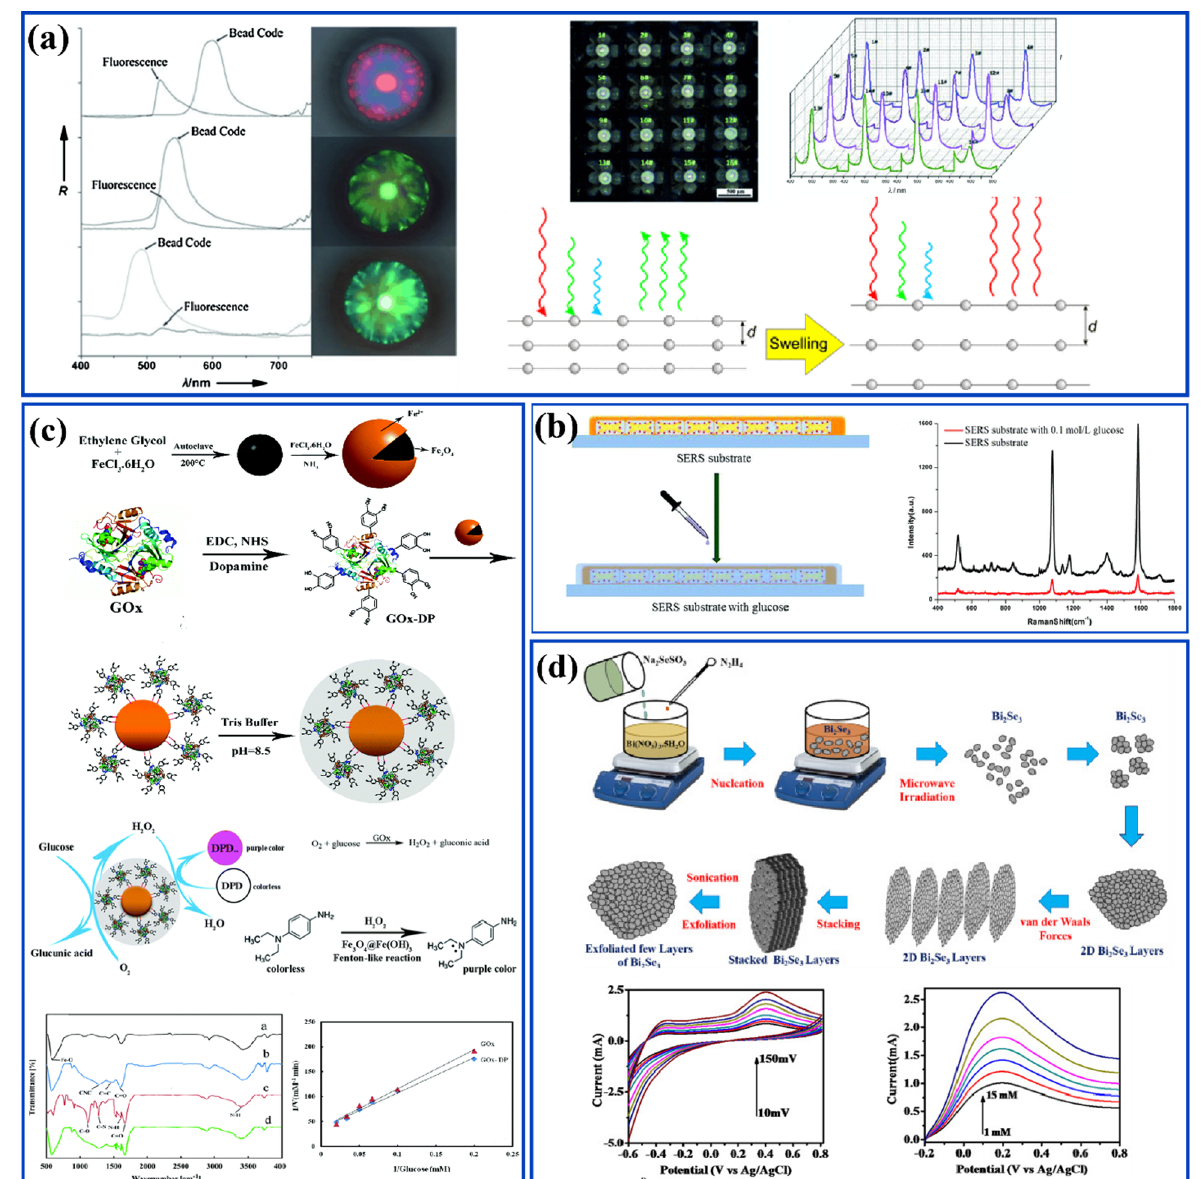
Figure 6. ( a ) Digital image of a 4×4 photonic crystal sensor array; reflection spectra of the beads in the 4×4 array; fluorescence and optical reflection spectra; physical and chemical sensing mecha- nism. (Reproduced with permission from Fenzl et al., Angew. Chem. Int. Ed., vol. 53, no. 13, pp. 3318–3335, 2014 [85]. Copyright 2014, John Wiley and Sons.) ( b ) Schematic representation of the probe preparation and testing of glucose. (Reproduced with permission from Zhu et al., J. Mater.